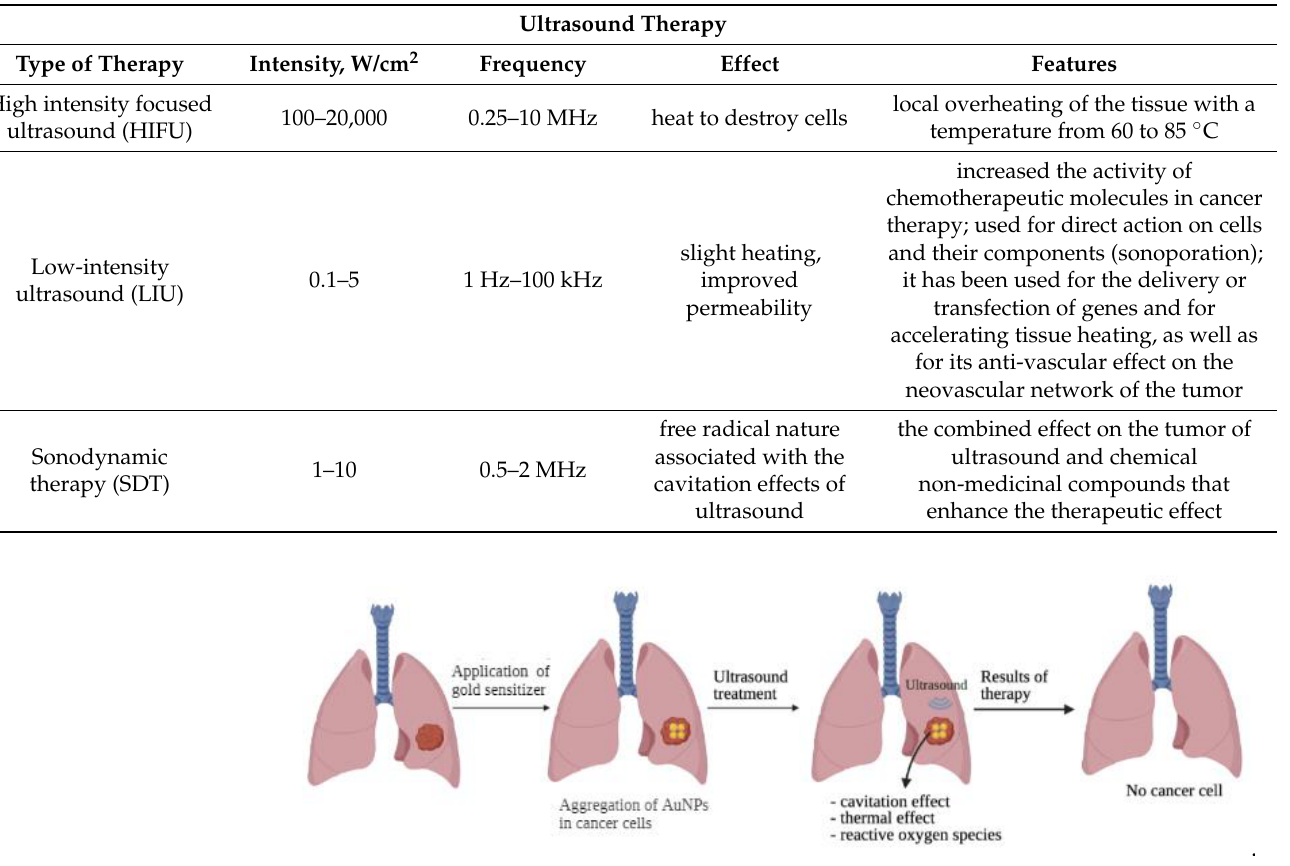
Figure 6. Schematic illustration of sonochemical therapy (created with BioRender.com). Table 1. Main methods of ultrasound therapy for cancer.